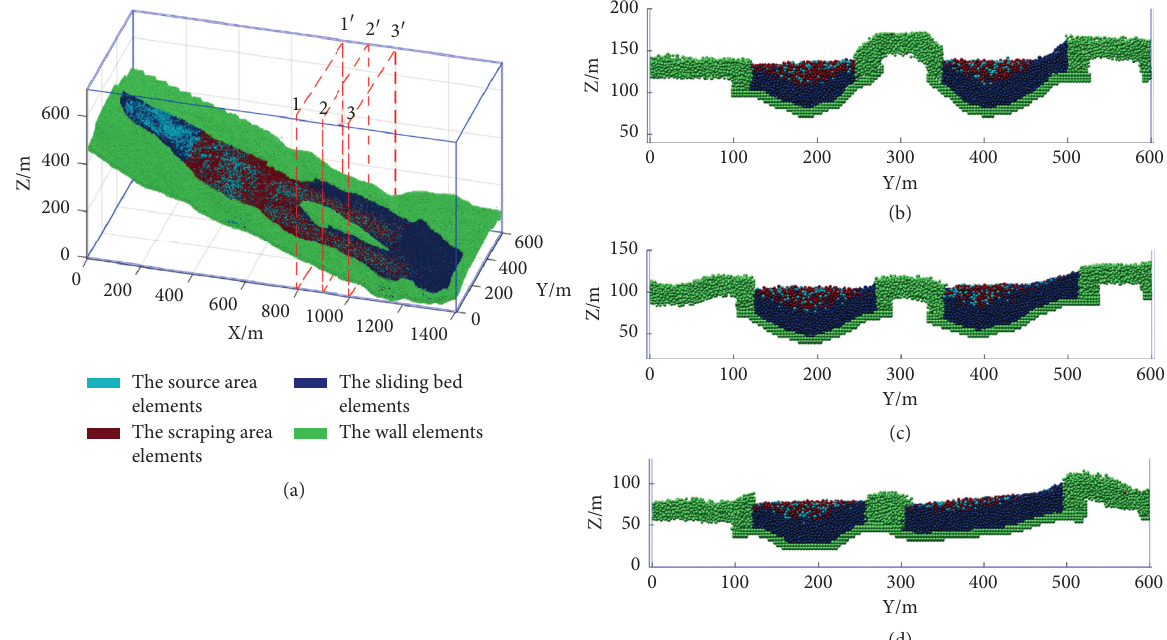
Figure 11: Final distribution and section of the landslide elements. (a) Distribution of all the elements; (b) 1-1 ′ section; (c) 2-2 ′ section; (d) 3-3 ′